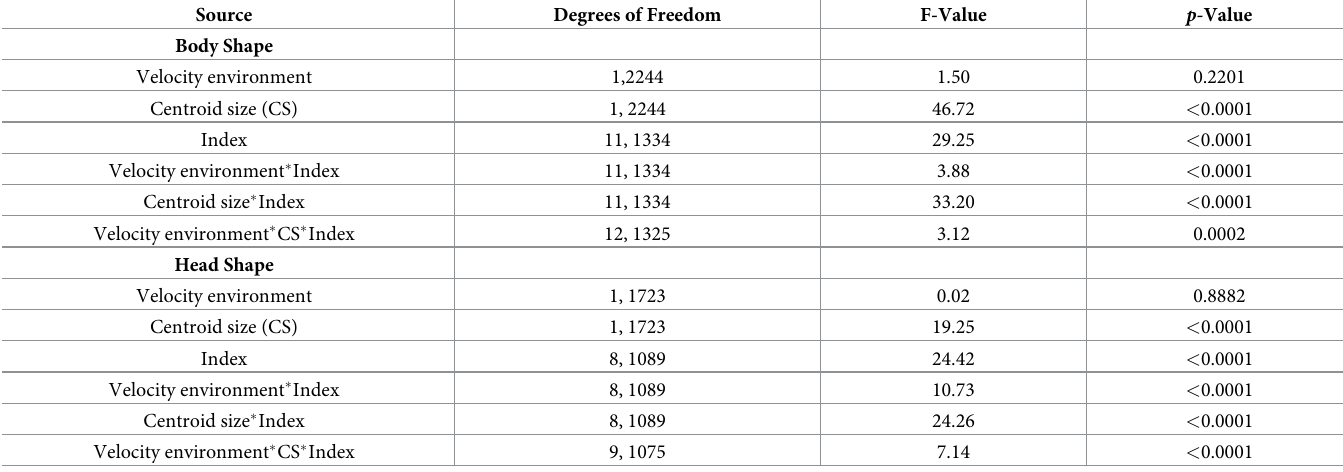
Table 2. Multivariate analysis of covariance effects for body shape and head shape.